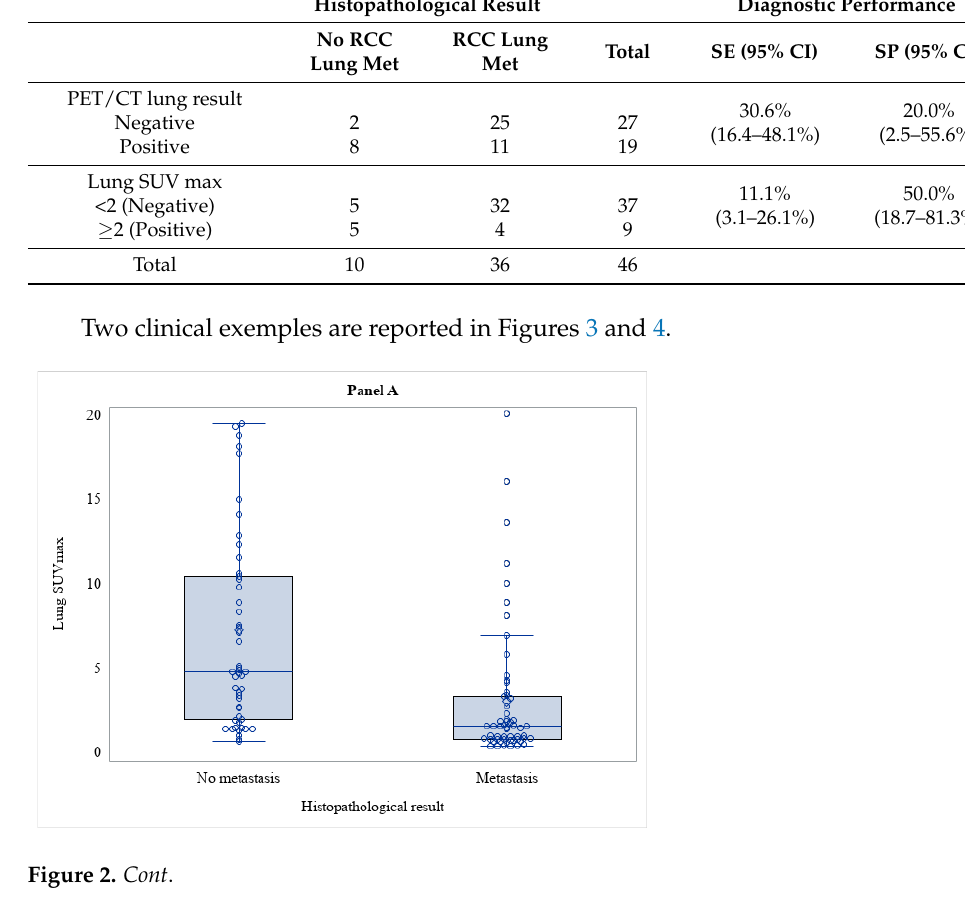
Table 3. Distribution of FDG-PET/CT semi-quantitative body parameters among lesions with and without metastases ( n = 107).